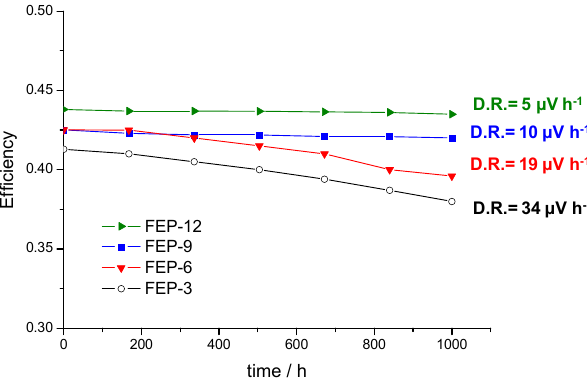
Figure 5. Fuel cell global efficiencies as a function of time and degradation rate values in constant current durability tests for cells assembled with GDMs based on different FEP content.